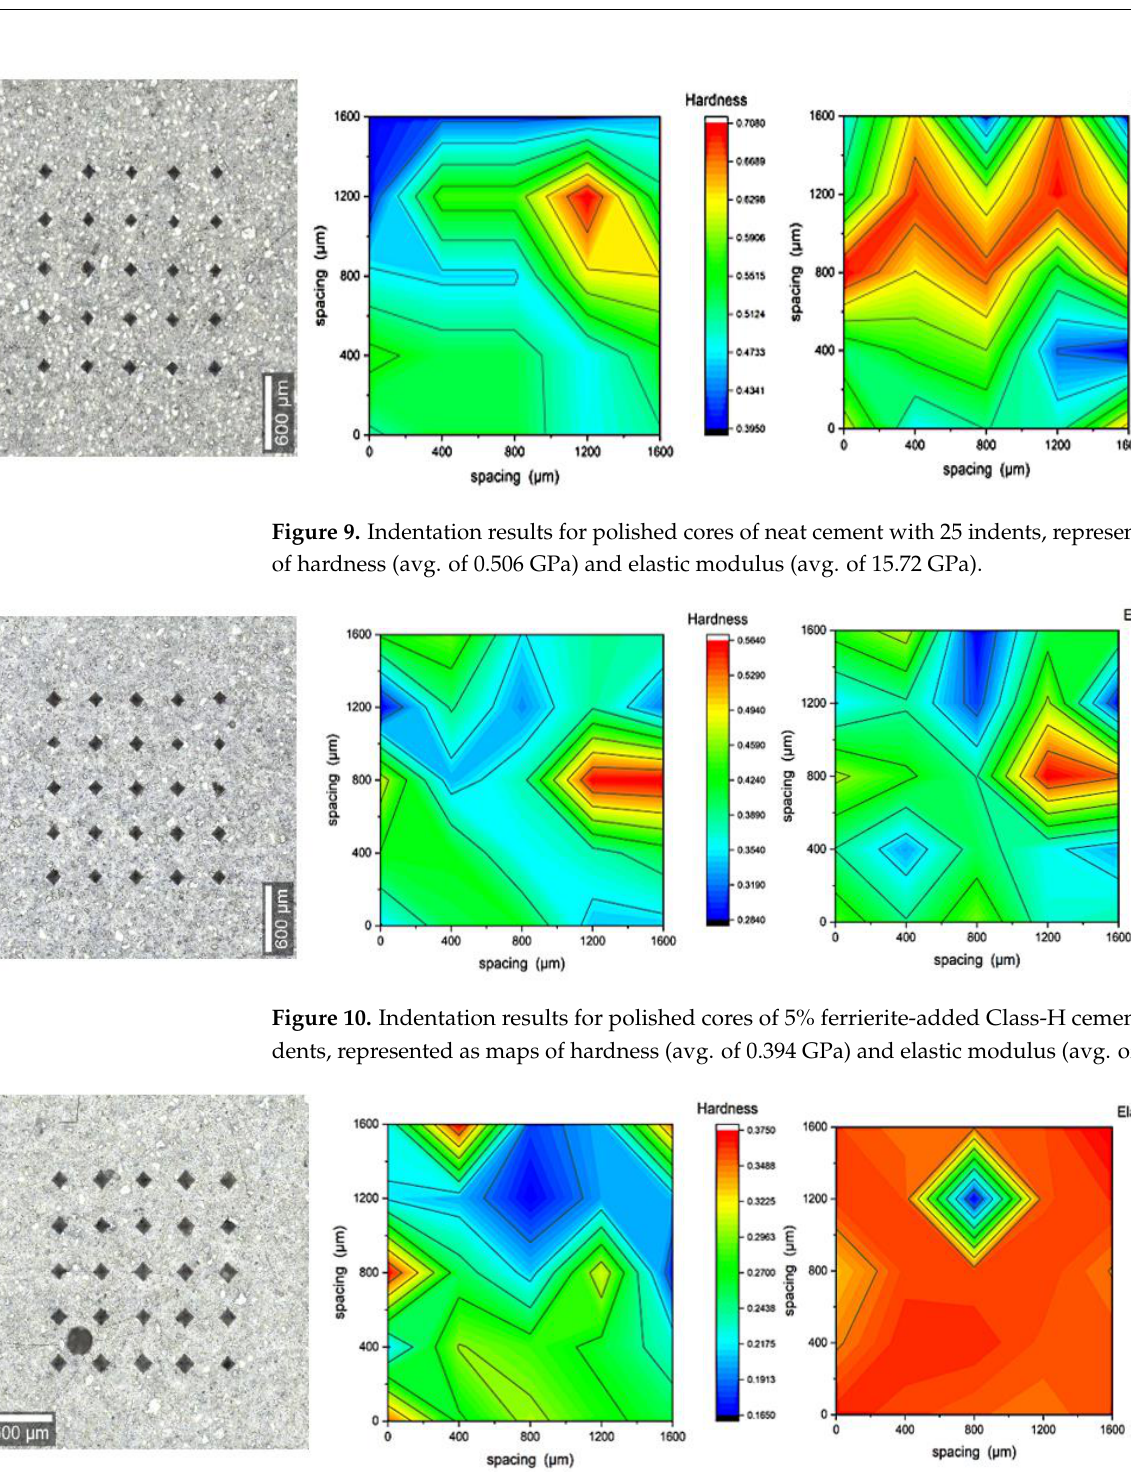
Figure 12. Indentation results for polished cores of 30% FER-added Class-H cement with 25 indents, represented as maps of hardness (avg. of 0.256 GPa) and elastic modulus (avg. of 7.88 GPa). Figure 13. An EDS map corresponding to an SEM image showing a single indent on neat cement. Indentation was conducted for the other formulations (for 5%, 15% and 30% ferrierite-added Class- H cement) as well, and SEM and EDS studies were undertaken to see if there is any noticeable sur- face chemical change upon failure. Future work is planned to test the indentation marks in a more detailed manner and to correlate them with the EDS studies to see if there is any chemical change in the matrix.